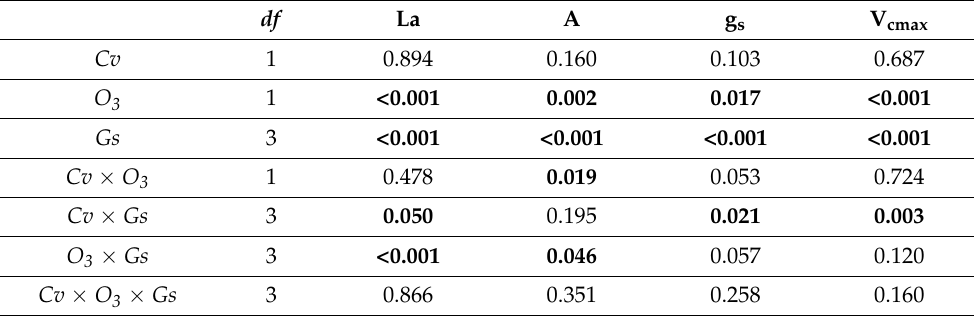
Table 2. p -values of three-way ANOVA for the effects of the cultivar ( Cv ; Claudio and Mongibello), growth stage ( Gs ; 7, 28, 50 and 70 days), ozone treatment ( O 3 ; 0 and 80 ppb, 5 h day − 1 ) and their interactions on leaf area (La), CO 2 assimilation rate (A), stomatal conductance (g s ) and maximum RuBP-saturated rate of carboxylation (V cmax ) of durum